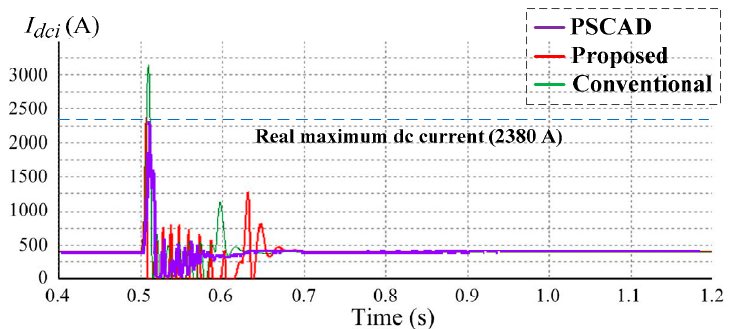
Figure 12. Inverter DC current for a single-phase line-to-ground fault. Table 7. Summary of the maximum DC voltages and currents at the inverter for the single-phase line-to-ground fault.